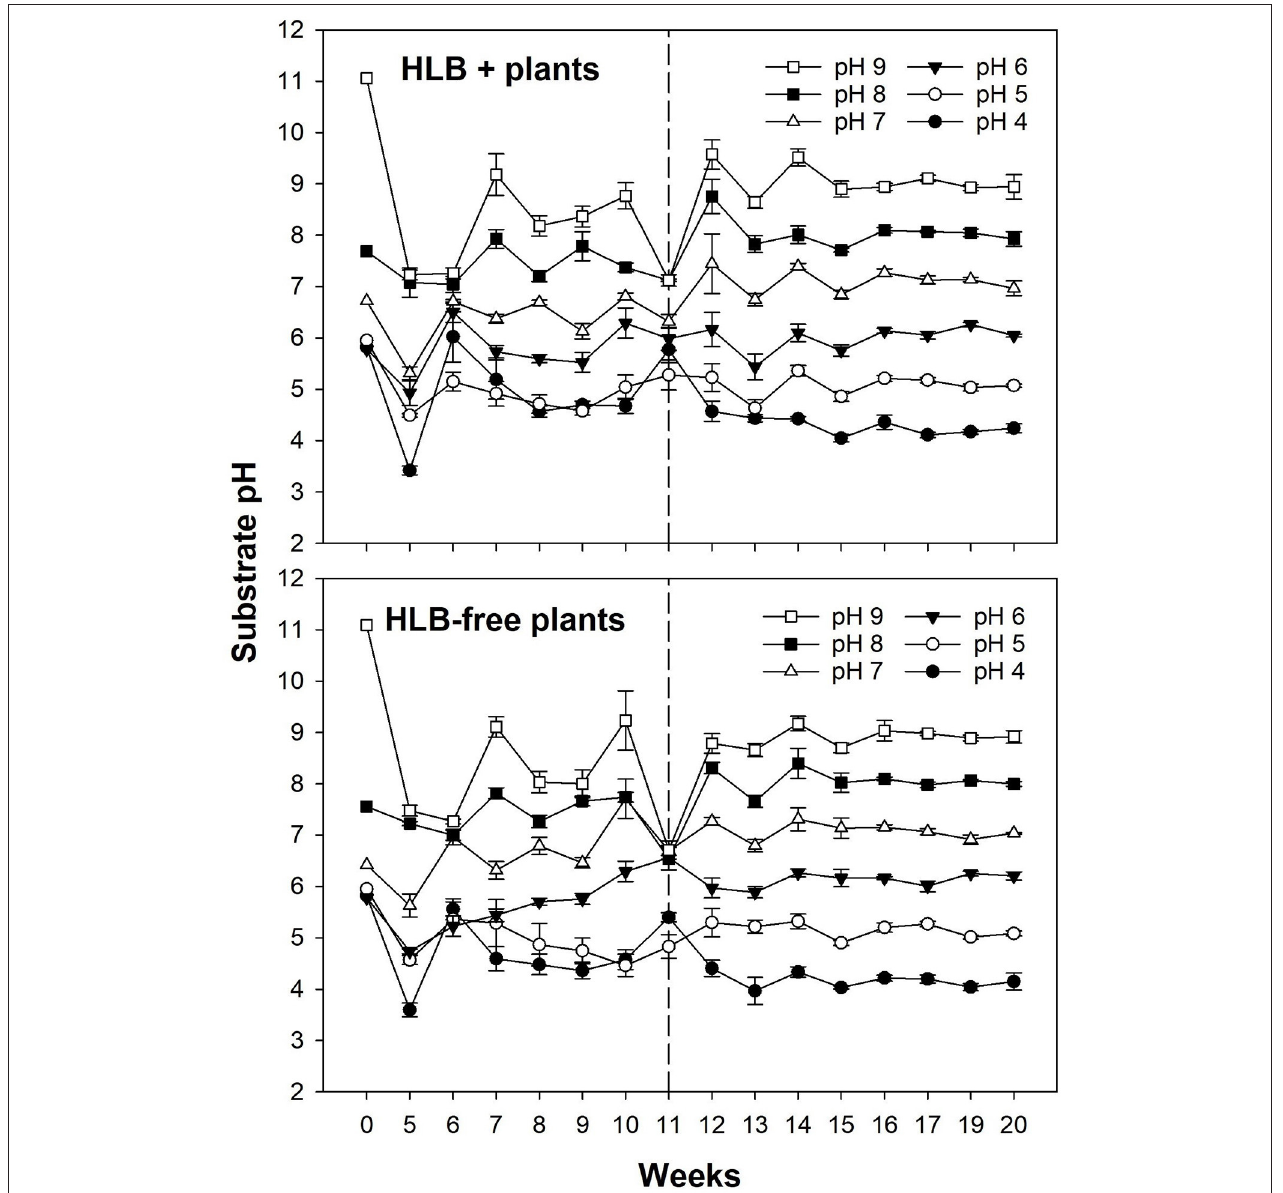
FIGURE 3 | Substrate pH of plants exposed to different HLB disease statuses [HLB-free or healthy (negative, HLB–) and HLB-affected (positive, HLB + )] under an increasing range of substrate pHs (4–9). The treatments were applied for 11 weeks until the top layer of substrate started being replaced weekly, clearly stabilizing the substrate pH. The dashed line at Week 11 (12 November, 2019) indicates the beginning of the experiment. Each data point represents the mean ± standard error ( n =